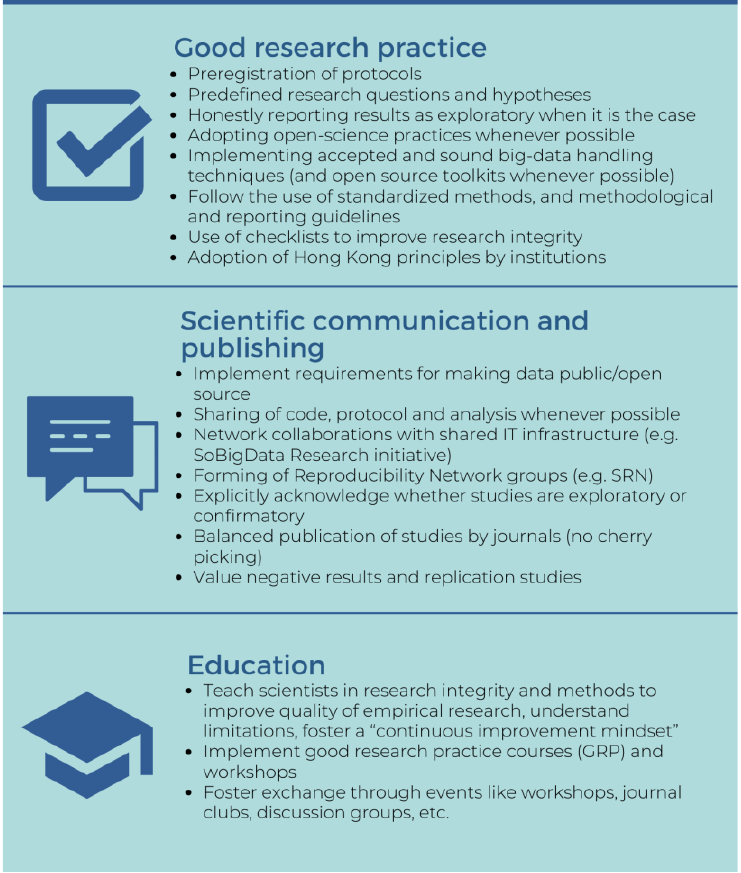
Figure 2. Approaches that address good research practice, scientific communication, and education are important to improve reproducibility and scientific integrity.